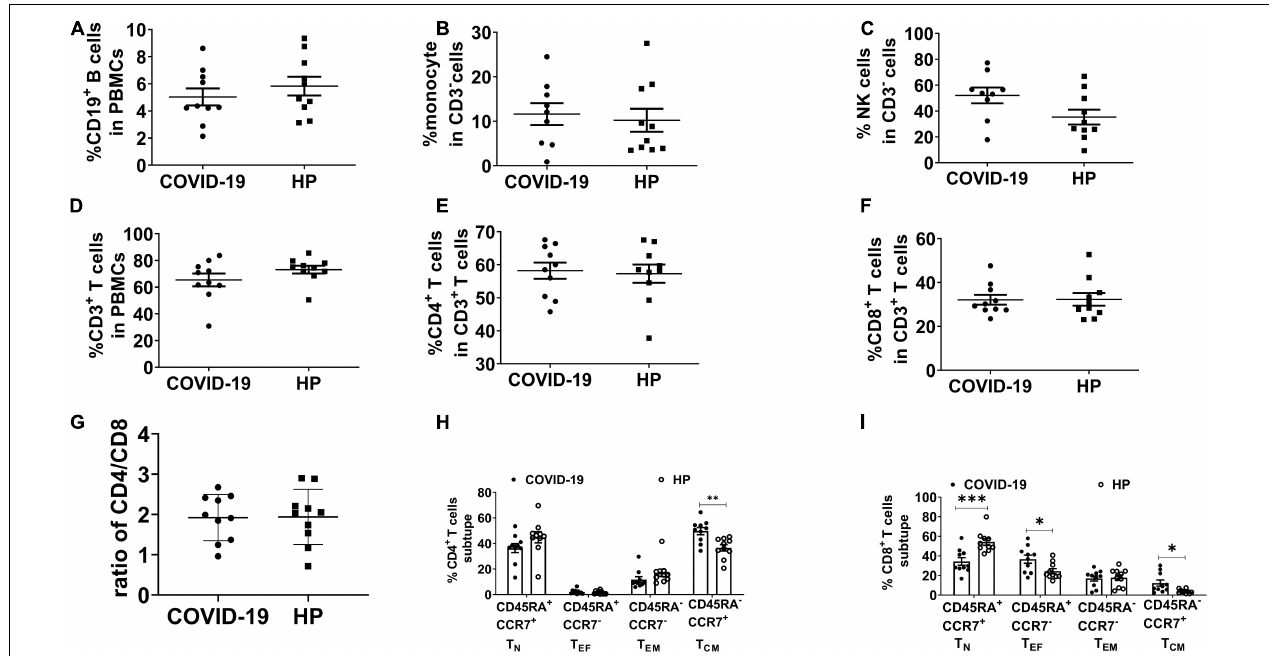
FIGURE 1 | Immunophenotyping of PBMC in recovered COVID-19 patients and HP. Multicolor FC was used to detect the frequency of (A) B cells (CD3 − CD19 + ), (B) monocytes (CD3 − CD16 − CD14 + ), (C) NK cells (CD3 − CD56 + CD16 + ), (D) CD3 + T cells, (E) CD4 + T cells (CD3 + CD4 + CD8 − ), and (F) CD8 + T cells (CD3 + CD4 − CD8 + ). (G) The ratio of CD4/CD8. (H,I) T CM (CD45RA − CCR7 + ), T N (CD45RA + CCR7 + ), T EF (CD45RA + CCR7 − ), and T EM (CD45RA − CCR7 − ) in 10 recovered COVID-19 patients and 10 HP. FC: flow cytometry; PBMCs: peripheral blood mononuclear cells; COVID-19: Coronavirus Disease-2019; HP, healthy people; T CM , central memory T cells; T N , naïve T cells; T EF , effector T cells; T EM , effector T memory cells. * P < 0.05, ** P < 0.01, *** P <